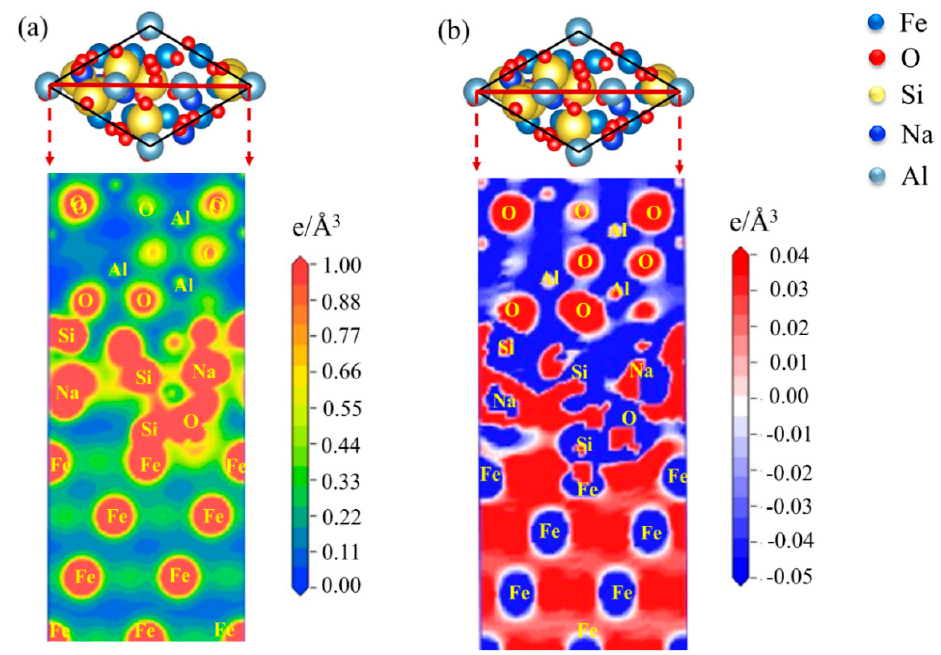
Figure 10. The ( a ) charge density and ( b ) charge density difference of the Fe − amorphous Na 2 SiO 3 − Al 2 O 3 interface at (111) crystal plane.